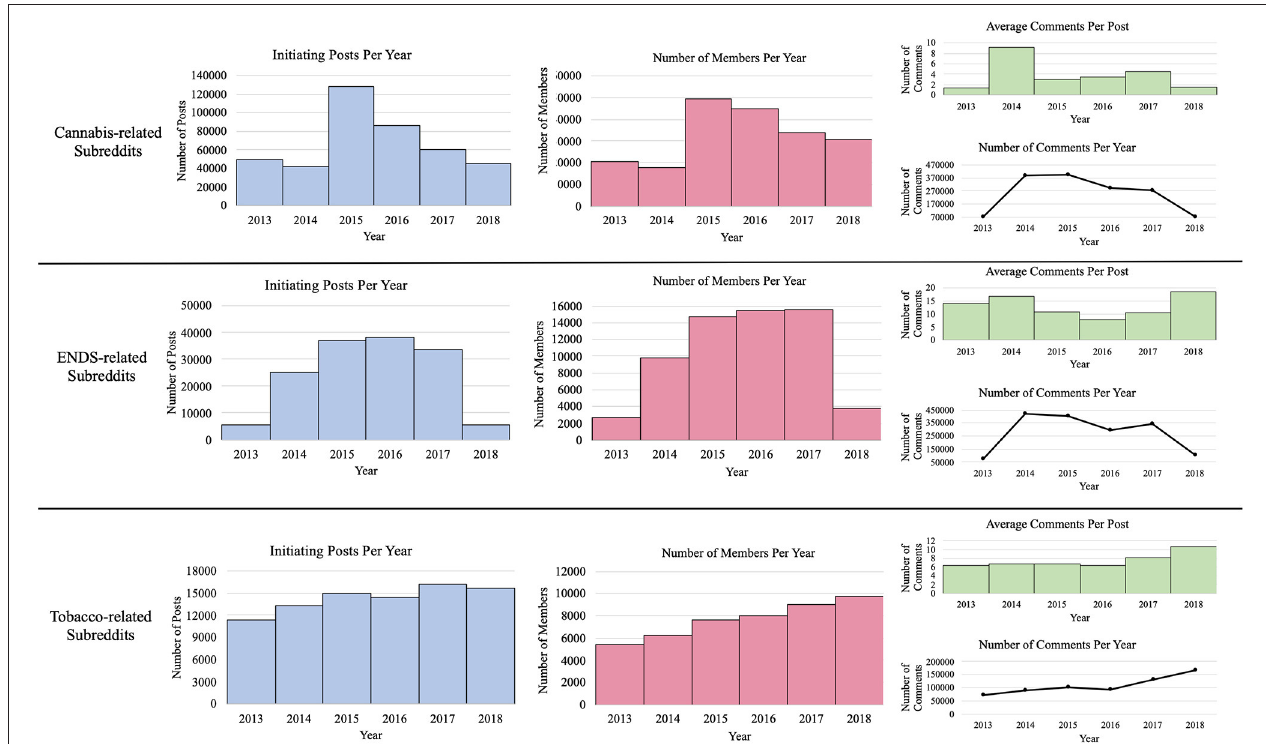
FIGURE 1 | Member and post statistics for macro-corpus, stratified by product